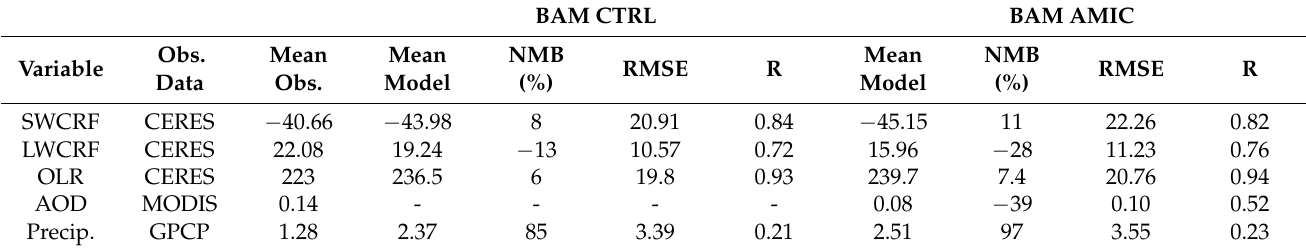
Table 3. Model performance statistics of cloud properties and precipitation for JFM2014 set of experiments. BAM CTRL BAM